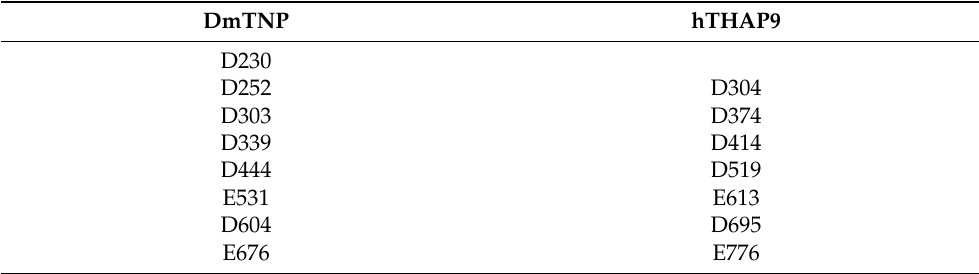
Table 1. List of conserved Asp and Glu residues (which were mutated) in the RNase-H fold of DmTNP and hTHAP9. Residues of each homolog, which are aligned with each other in Figure 3, are adjacent to each other in the same